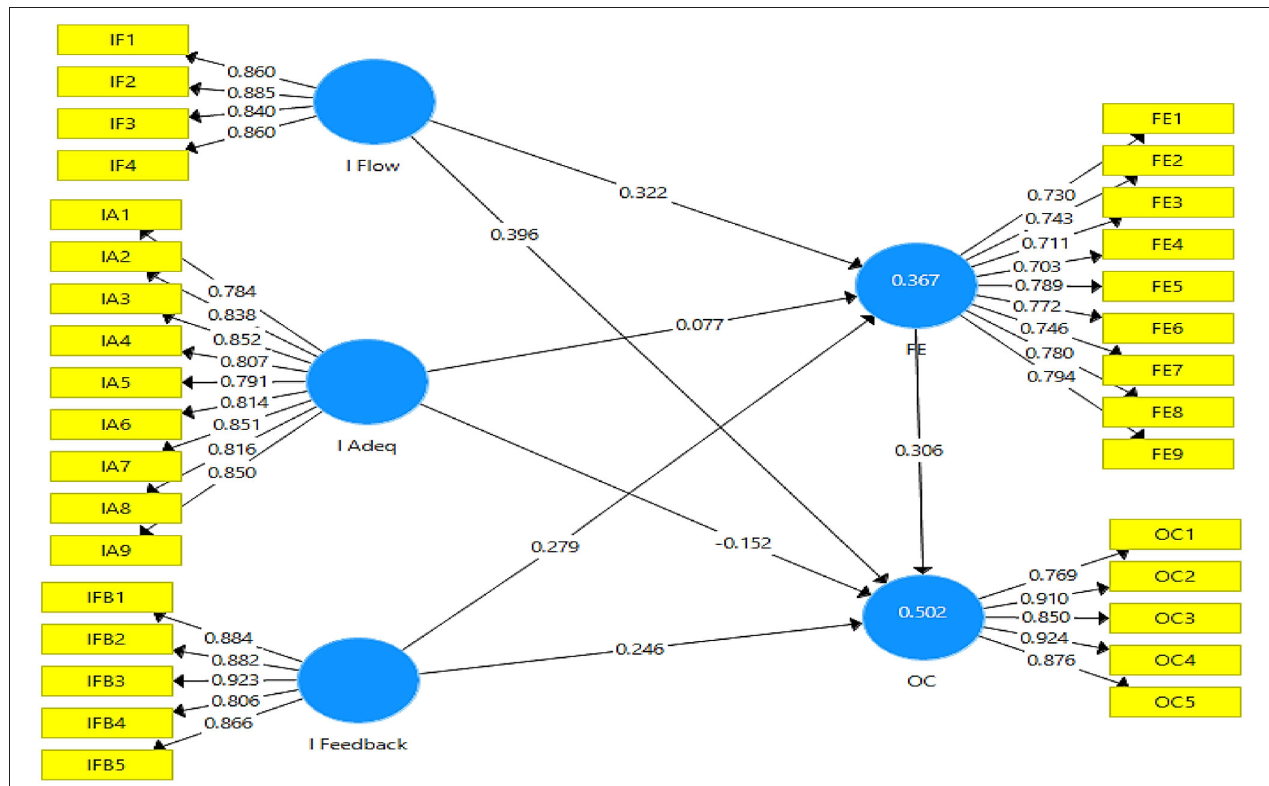
FIGURE 2 | Output of measurement model. IFlow, Information flow; IAdeq, Information adequacy; IFeedback, Information feedback; FE, Faculty engagement; OC, Organizational commitment.